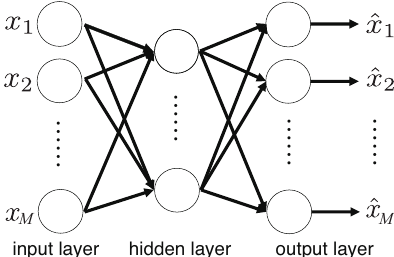
Figure 4. Structure of an AE. An AE consists of an input layer, a hidden layer, and an output layer. x 1 , · · · , x M and ˆ x 1 , · · · , ˆ x M are the input variables and output variables of the AE, respectively. Circles denote units that express activation